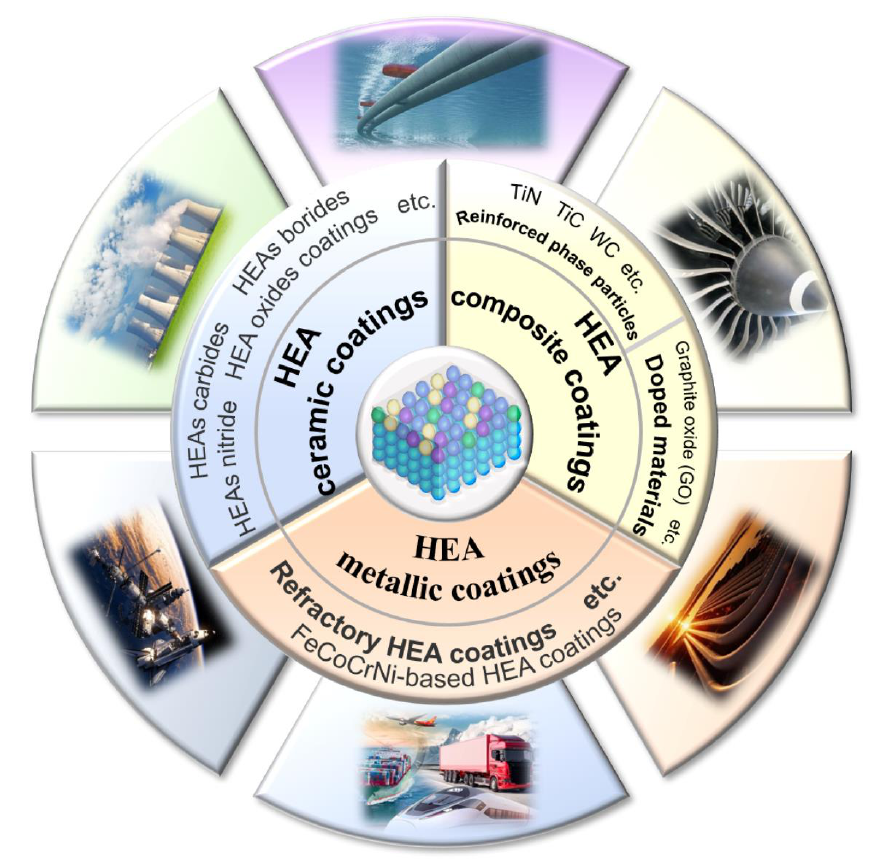
Figure 2. Classification of HEA coating. Based on the compositions and applications of HEA coatings, it is divided into metallic coatings, composite coatings, and ceramic coatings.